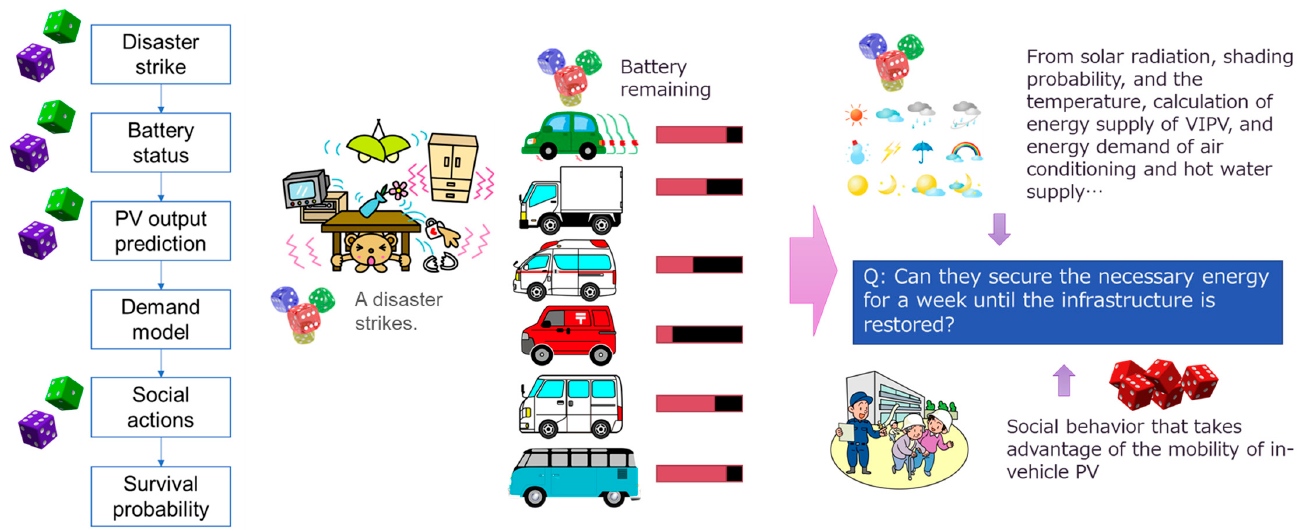
Figure 4. G raphical fl owchart of the Monte Carlo simulation. Figure 4. Graphical flowchart of the Monte Carlo simulation.